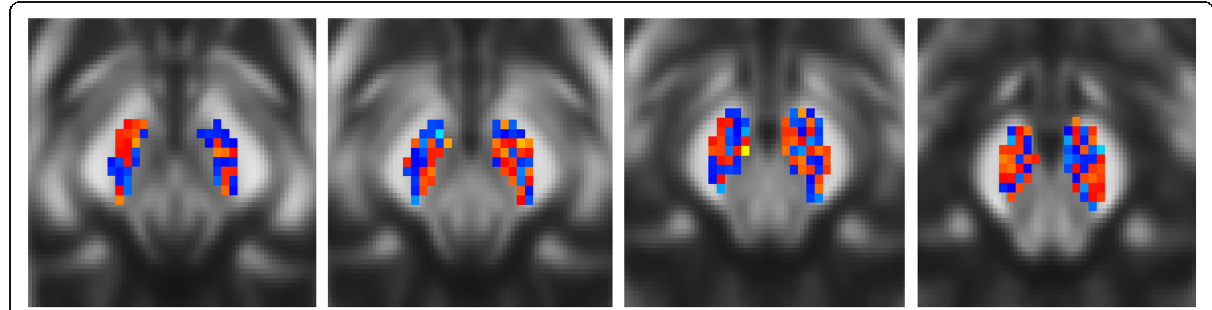
Fig. 2 Weight maps of FA bSVM (shown on axial midbrain slices). The pattern indicates random weighting of FA values for the purpose of classification (comparable to the other investigated diffusion metrics and the MKL, data not shown here). Former studies demonstrated altered diffusion metrics in the occipital portions of the SN [13]. However, interpretability is limited e.g. due to the small ROI